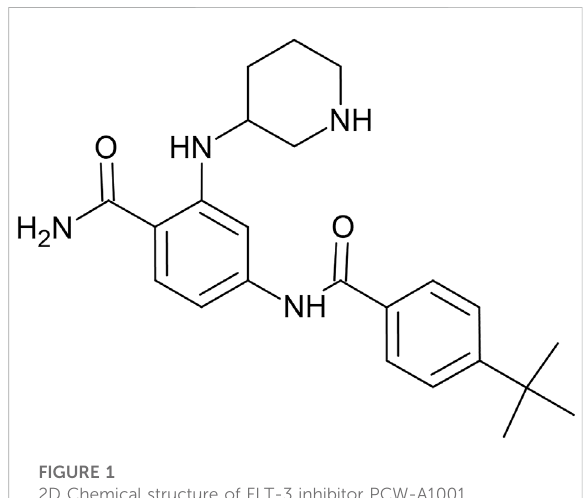
FIGURE 1 2D Chemical structure of FLT-3 inhibitor